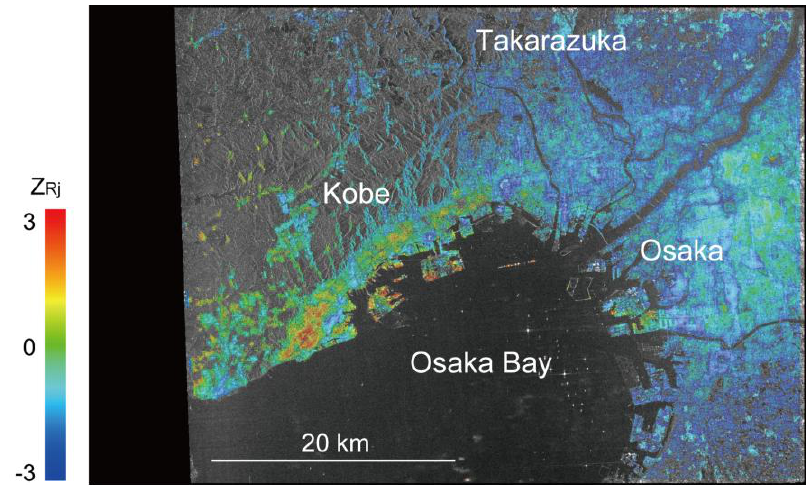
obtained from Rj